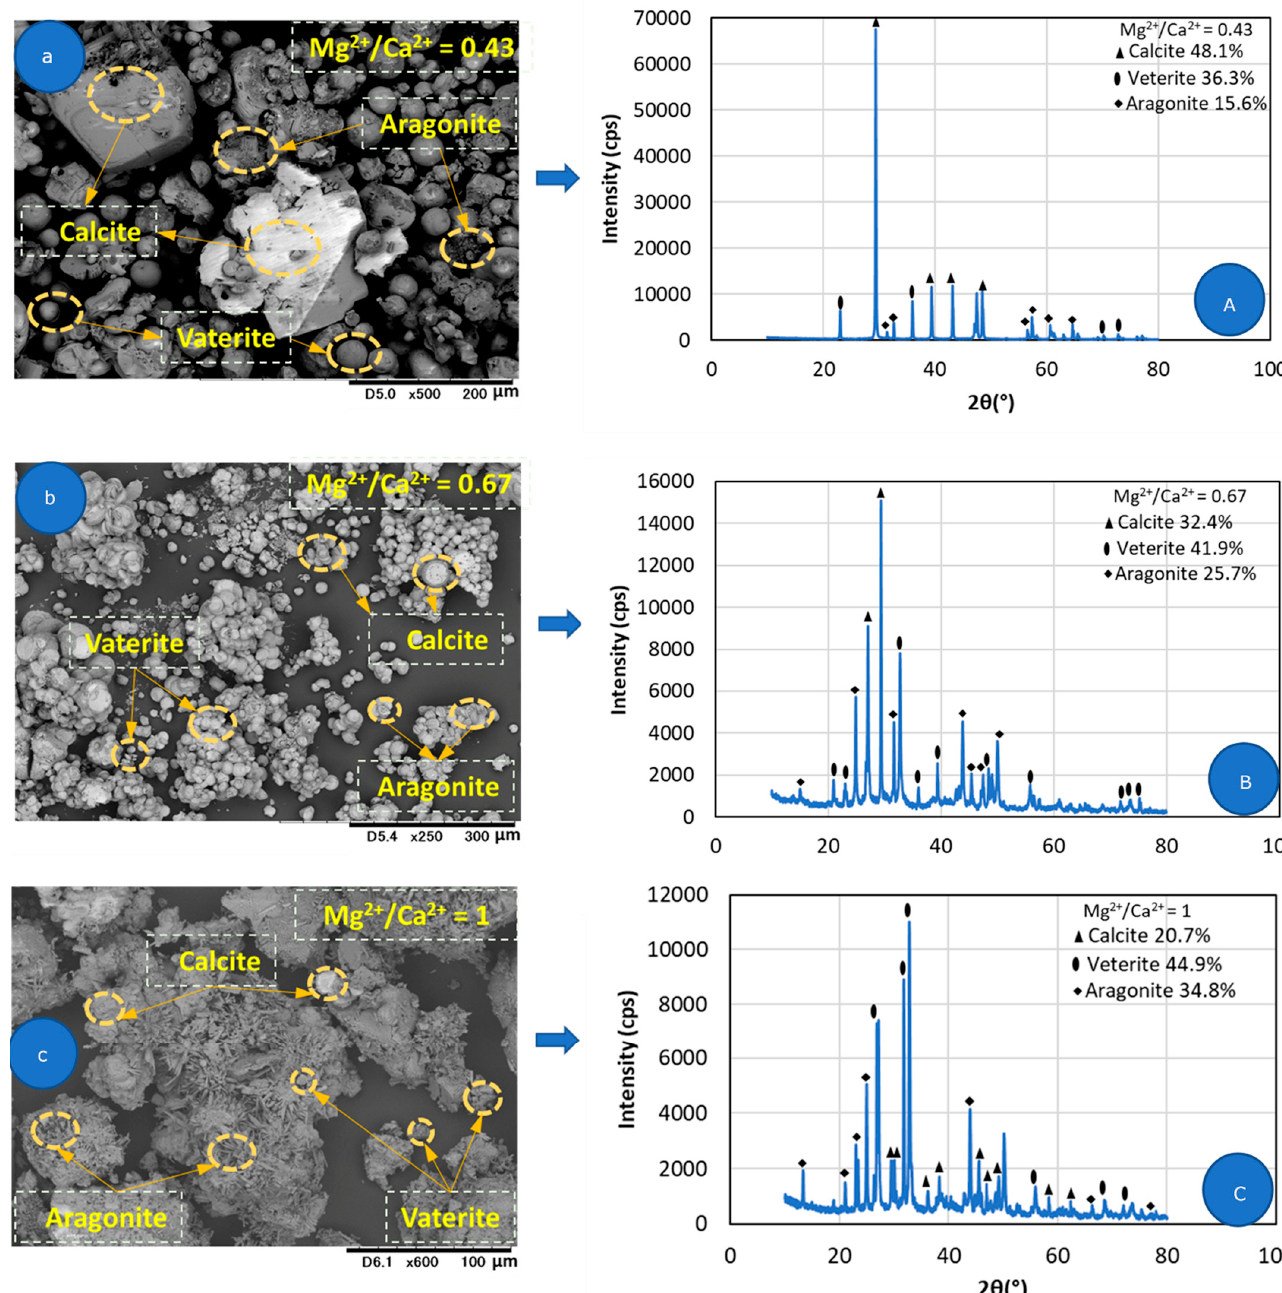
Figure 10. SEM images of the precipitated CaCO 3 crystals with different Mg 2+ /Ca 2+ ratios ( a – c ) and their subsequent XRD analysis to confirm the polymorph of the crystals ( A – C ).